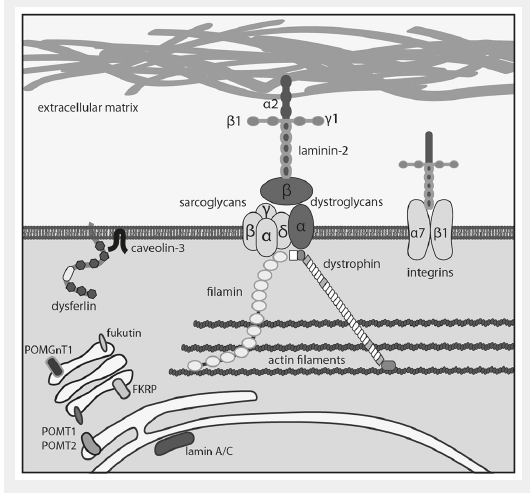
Figure 1 Illustration of proteins and potential targets involved in muscular dystrophies. Schematic representation of the localisation and interaction of selected proteins involved in muscular dystrophies. Dystrophin links the extracellular matrix to the actin cytoskeleton via the dystrophin- associated glycoprotein complex (DGC). Absence of dystrophin results in destabilisation of the DGC. Some genes mutated in muscular dystrophies encode proteins responsible for the correct glycosylation of dystroglycan, necessary for interaction with the extracellular matrix. The tail anchored membrane protein dysferlin is involved in membrane repair. FKRP = fukutin-related protein; POMT = protein O-mannosyl